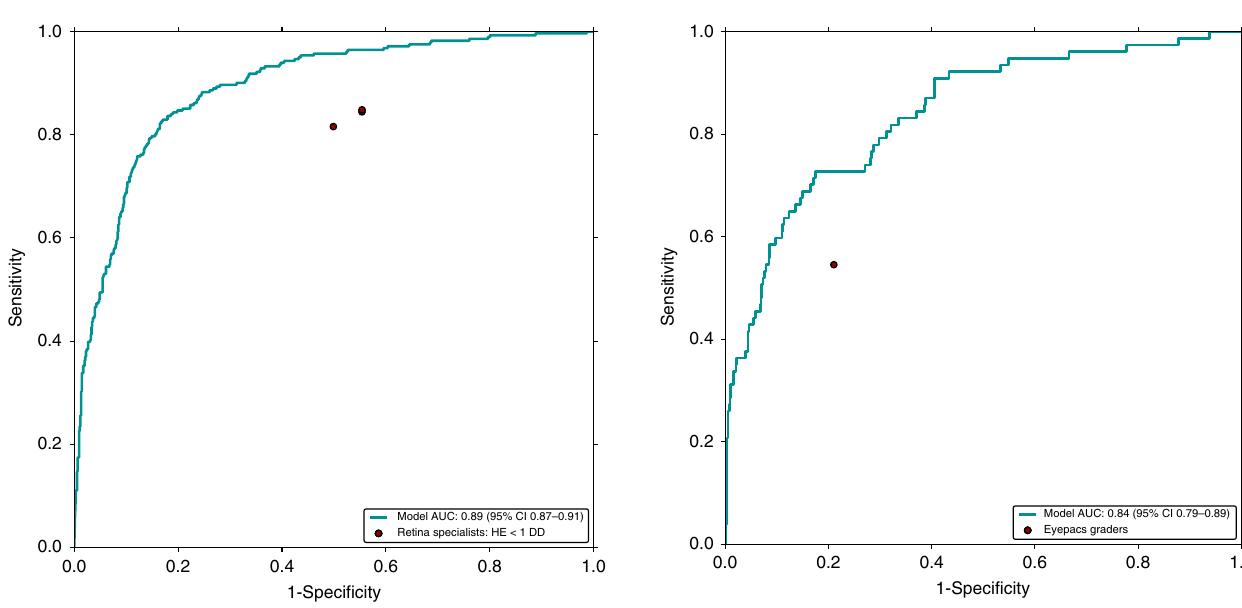
Fig. 2 Receiver operating characteristic curve of the model compared to retinal specialists. The retinal specialists ’ grades for predicting ci-DME on the primary clinical validation set are shown as red dots. All methods (i.e., the model and retinal specialists) rendered their grades using monoscopic fundus images only. The ground truth for ci-DME was derived using OCT (center point thickness ≥ 250 μ m).